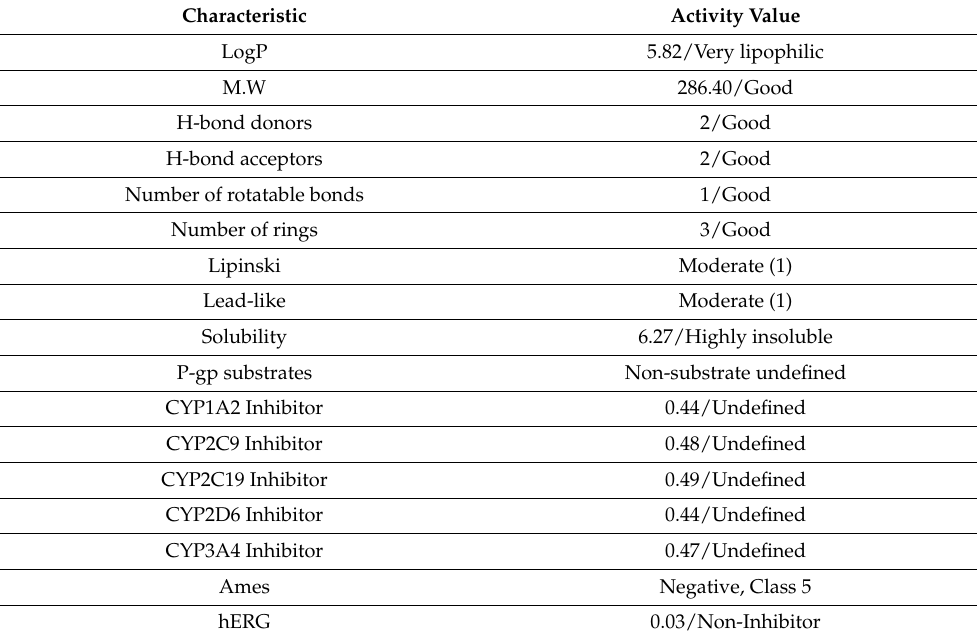
Table 1. ADME/toxicity and druggability of Ebractenoid